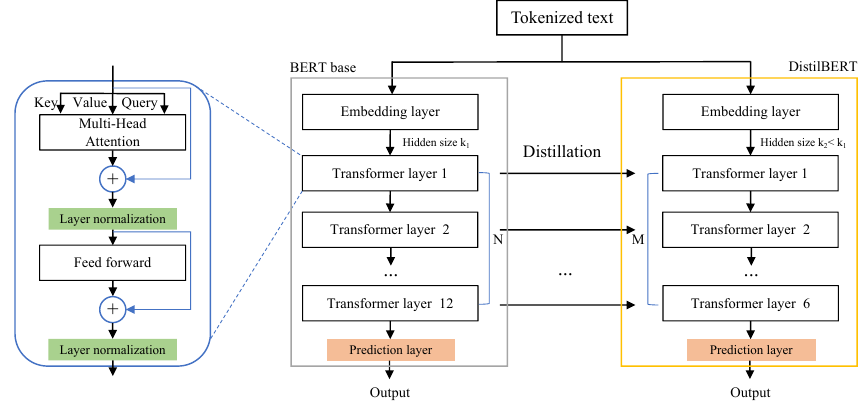
Figure 2. The DistilBERT model architecture and